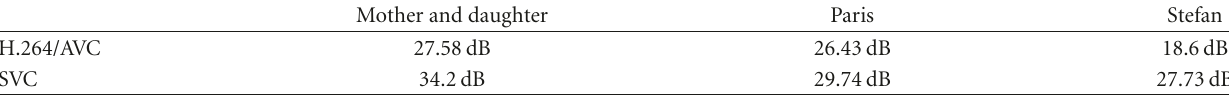
Table 1: Performance comparison between H.264 (one RTP stream) and SVC (2 RTP streams: base layer and SNR refinement).